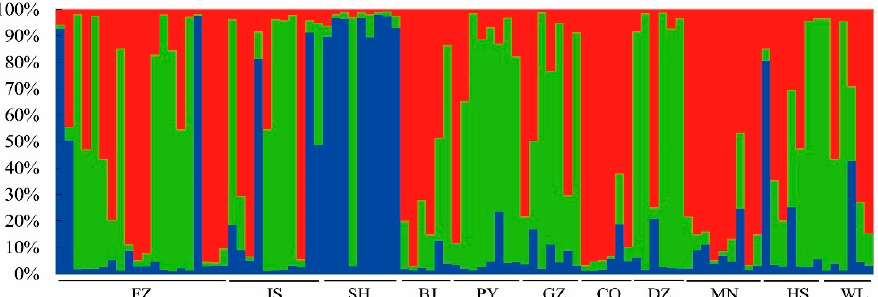
Figure 1. Δ K deviation curve. Figure 1. ∆ K deviation curve.